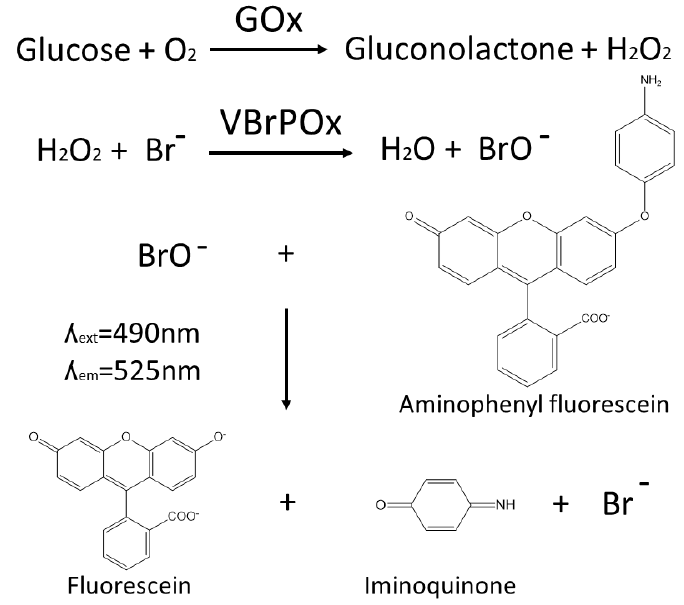
Figure 1. A schematic showing the reaction pathway for the vanadium bromoperoxide-coupled fluorescence assay for the detection of glucose oxidase activity within aqueous microdroplets.